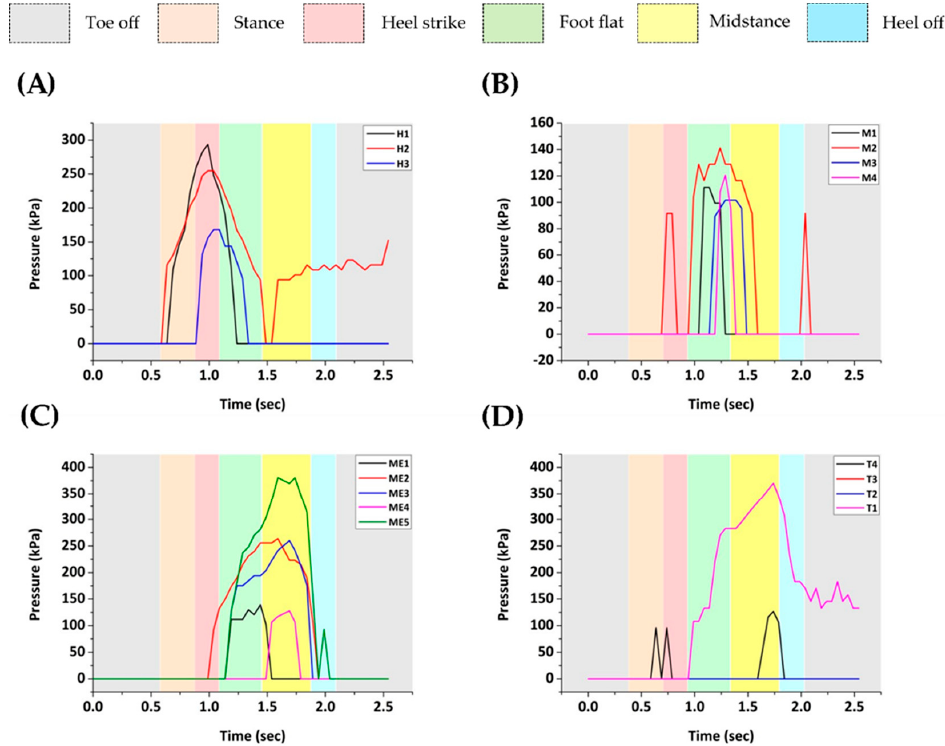
Figure 13. Real-time plantar pressure signals obtained from the right foot of the subject during a normal gait cycle using the developed smart insole system. Sensors monitored four areas: ( A ) calcaneus, ( B ) plantar arch, ( C ) metatarsals and ( D ) phalanges.